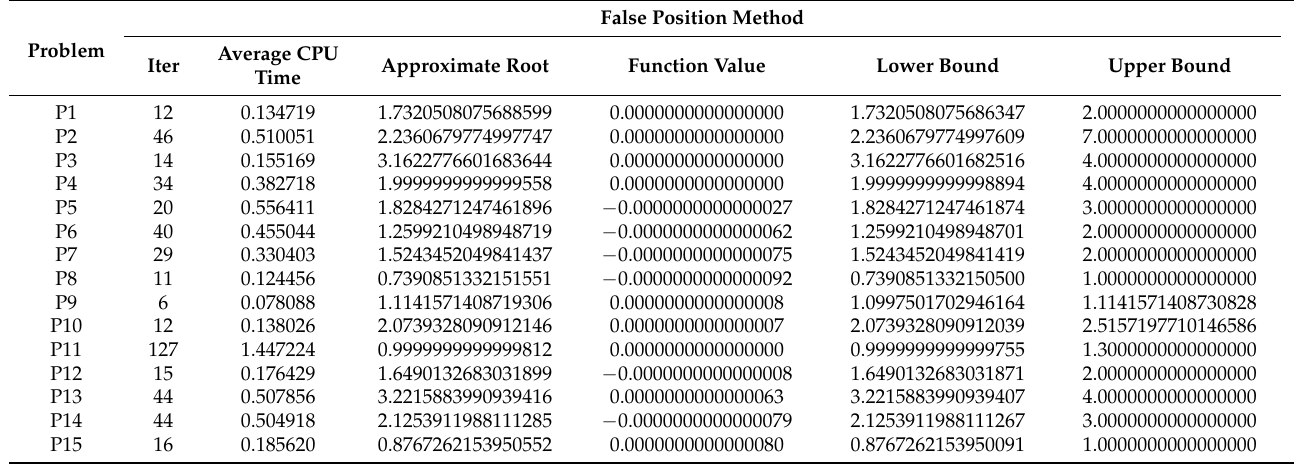
Table 5. Solutions of fifteen problems by the false position method.